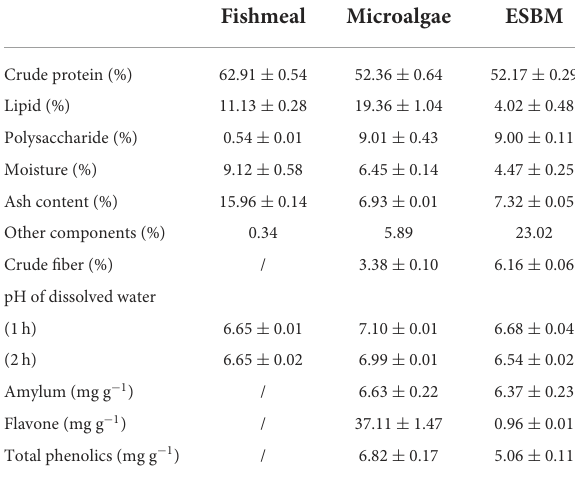
TABLE 1 Nutritional analysis for fishmeal, microalgae, and enzyme-treated soybean meal (ESBM).